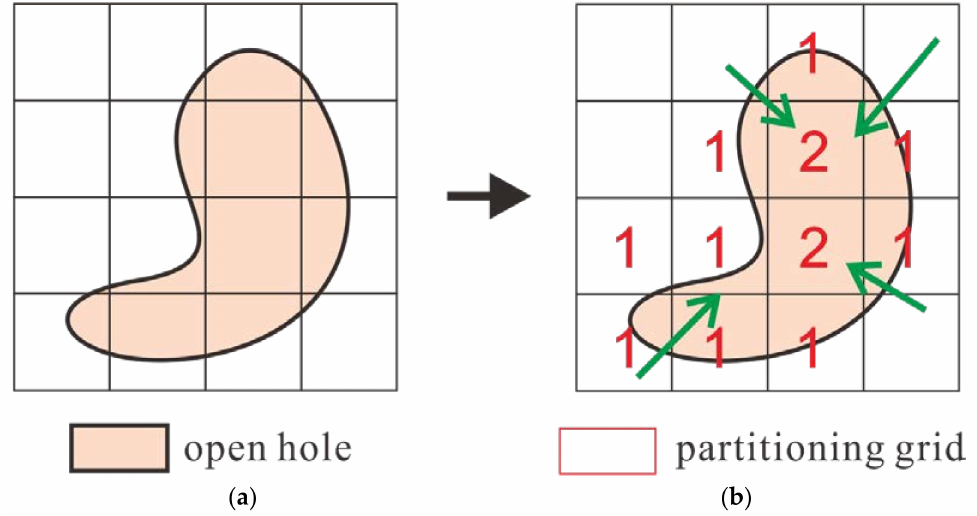
Figure 6. Calculation of hierarchical relationships: ( a ) original partitioning grid and open holes; ( b ) hierarchical relationship calculation for the open